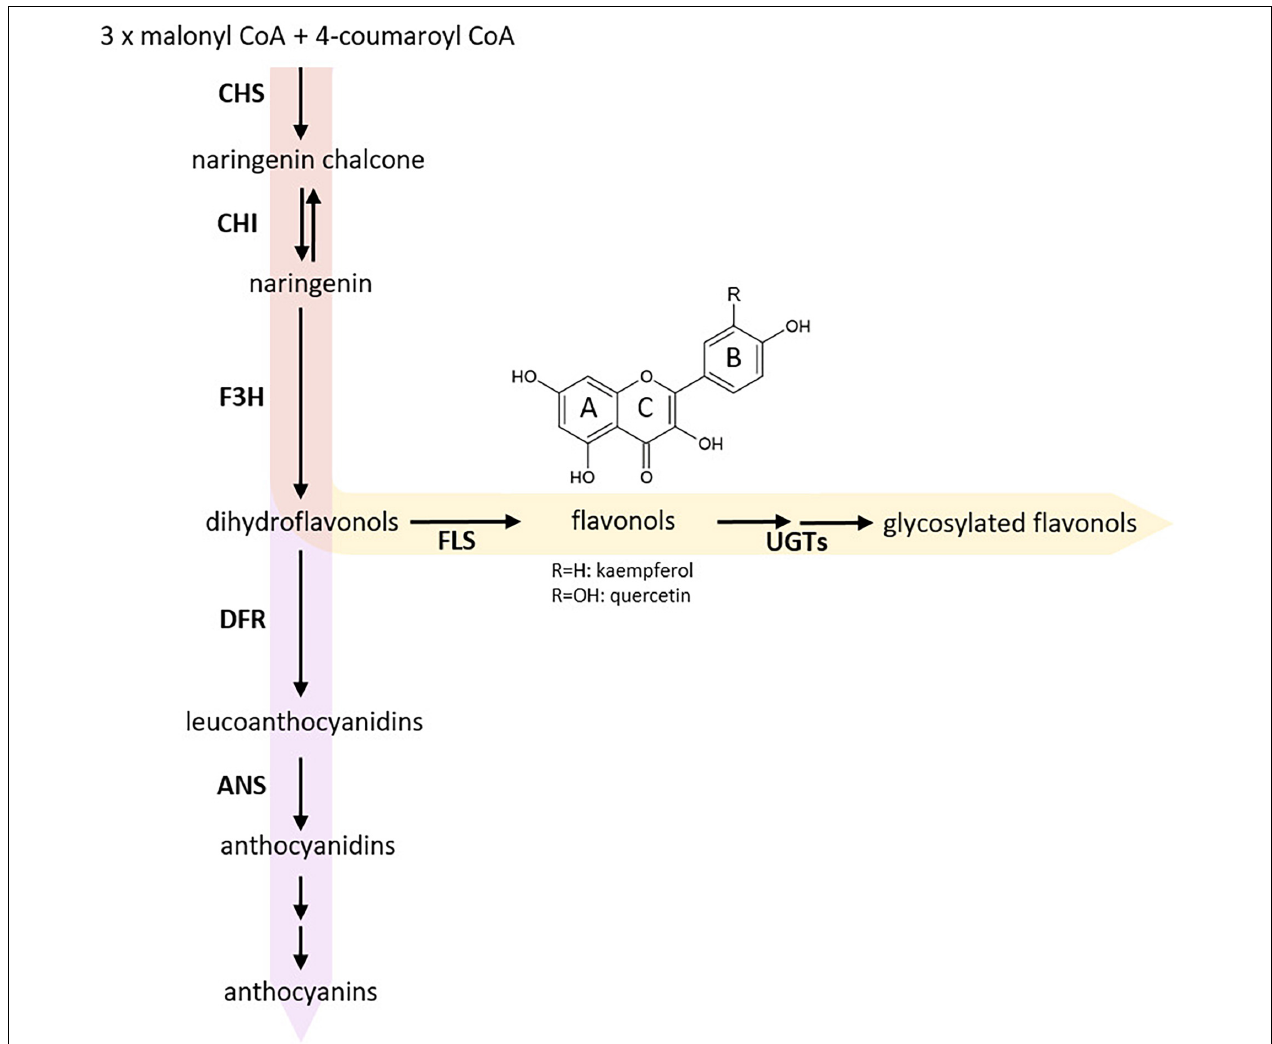
FIGURE 1 | Simplified scheme of flavonoid biosynthesis. The flavonol biosynthesis pathway (highlighted via an orange arrow) is part of the flavonoid biosynthesis, which also includes the anthocyanin pathway (highlighted via a violet arrow) (modified after Winkel-Shirley, 2001). The metabolic flux into the flavonol biosynthesis is influenced by dihydroflavonol 4-reductase (DFR) as it competes with FLS for substrates. Enzyme names are abbreviated as follows: chalcone synthase (CHS), chalcone isomerase (CHI), flavanone 3-hydroxylase (F3H), flavonol synthase (FLS), UDP-glycosyltransferases (UGTs), anthocyanidin synthase